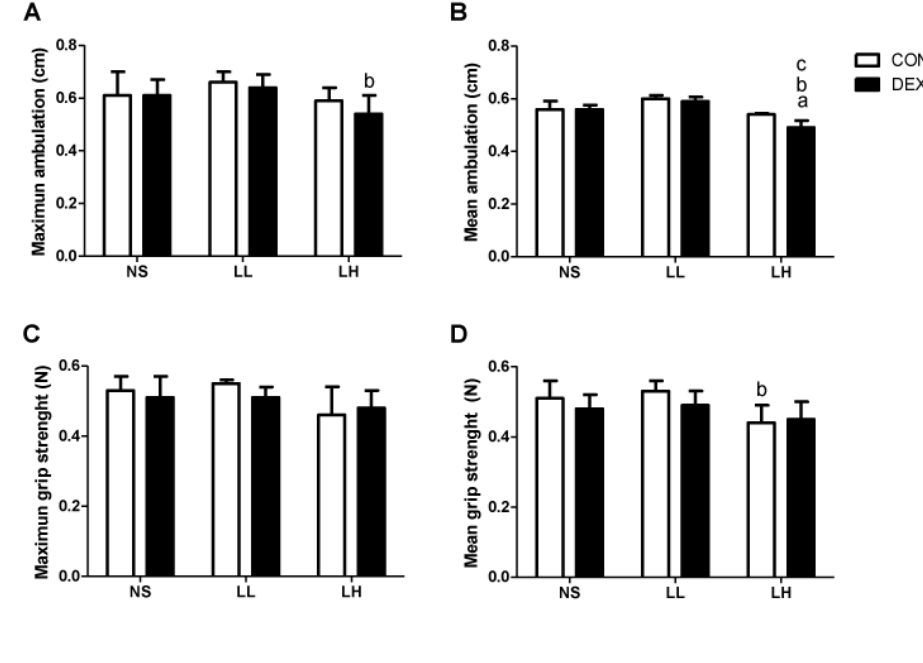
Figure 3. Muscle functional parameters. ( A ) Maximum ambulation (cm); ( B ) Mean ambulation (cm); ( C ) Maximum grip strength (N); ( D ) Mean grip strength (N). Values are expressed as mean ± S.E.M. a Different from CON-NS ( p < 0.05); b Different from CON-LL ( p < 0.05); and c Different from CON-LH ( p < 0.05).